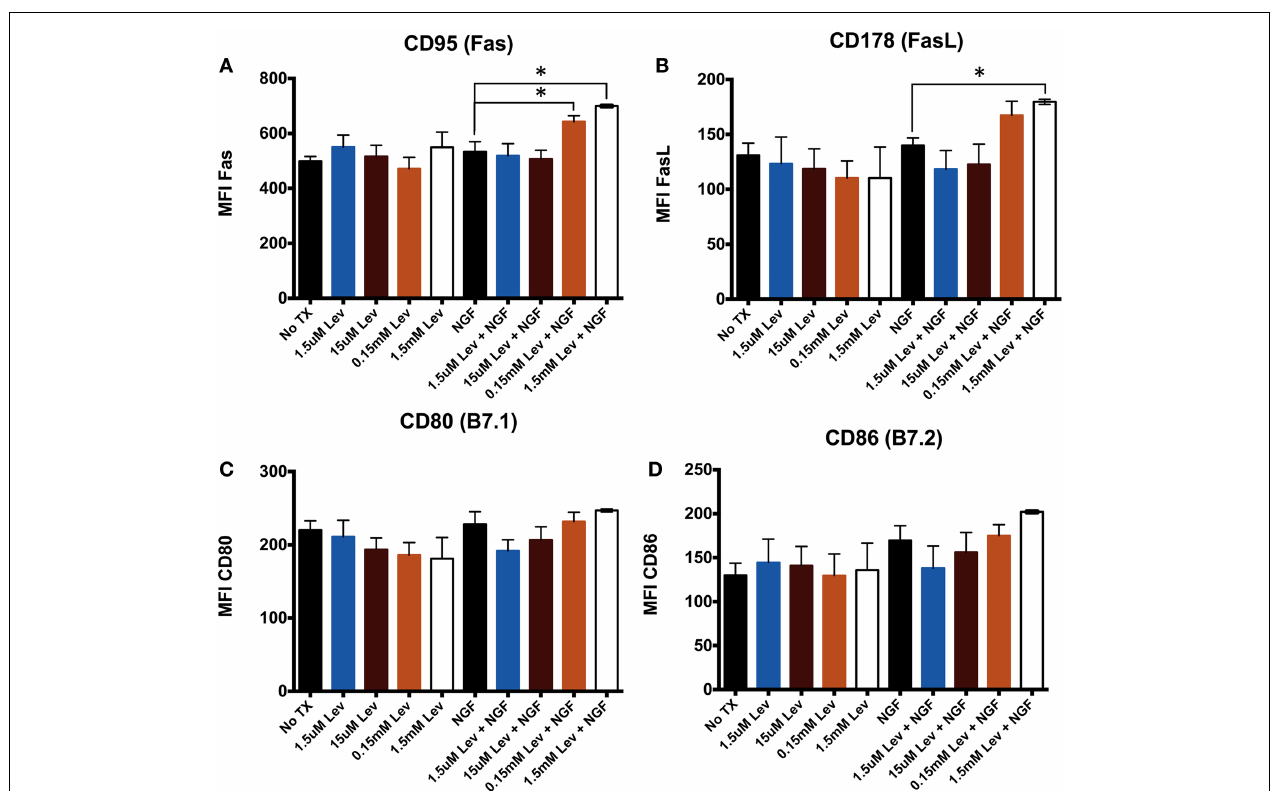
FIGURE 2 | Levetiracetam alters cell surface Fas expression on C17.2 cells . Mean flouresecence intensity (MFI) as measure of relative expression level of (A) CD95, (B) CD178, (C) CD80, and (D) CD86 48h after treatment with or without Lev. *Denotes a p -value <